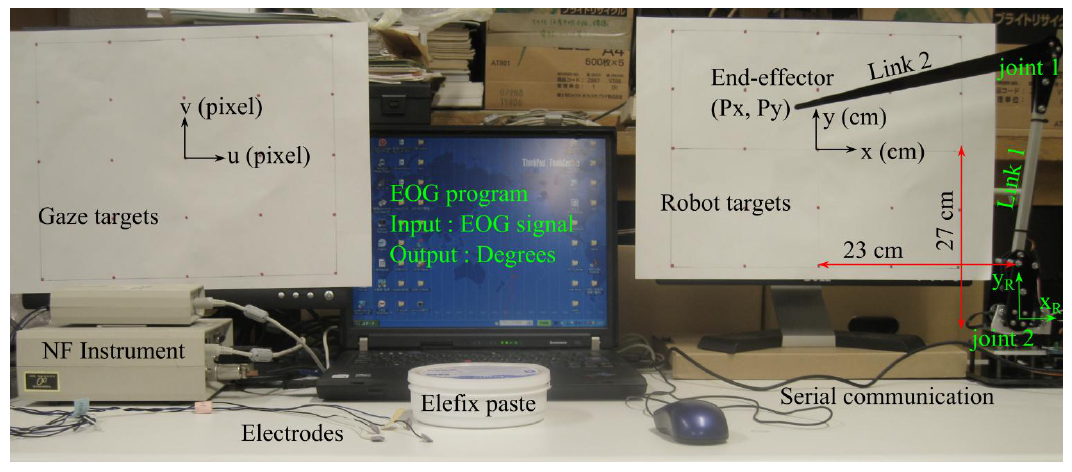
Figure 5. Experiment setup of robot control system using